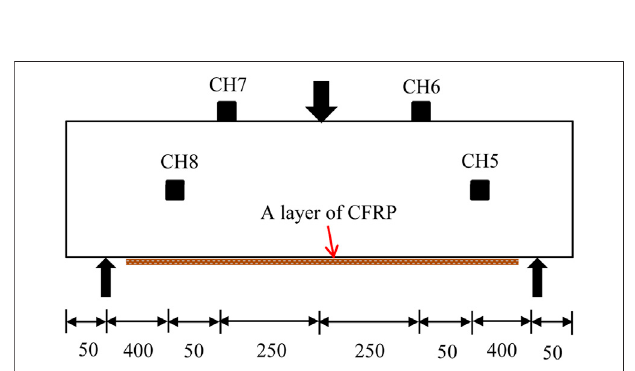
FIGURE 5 | Schematic diagram of the beam set up (unit in mm).